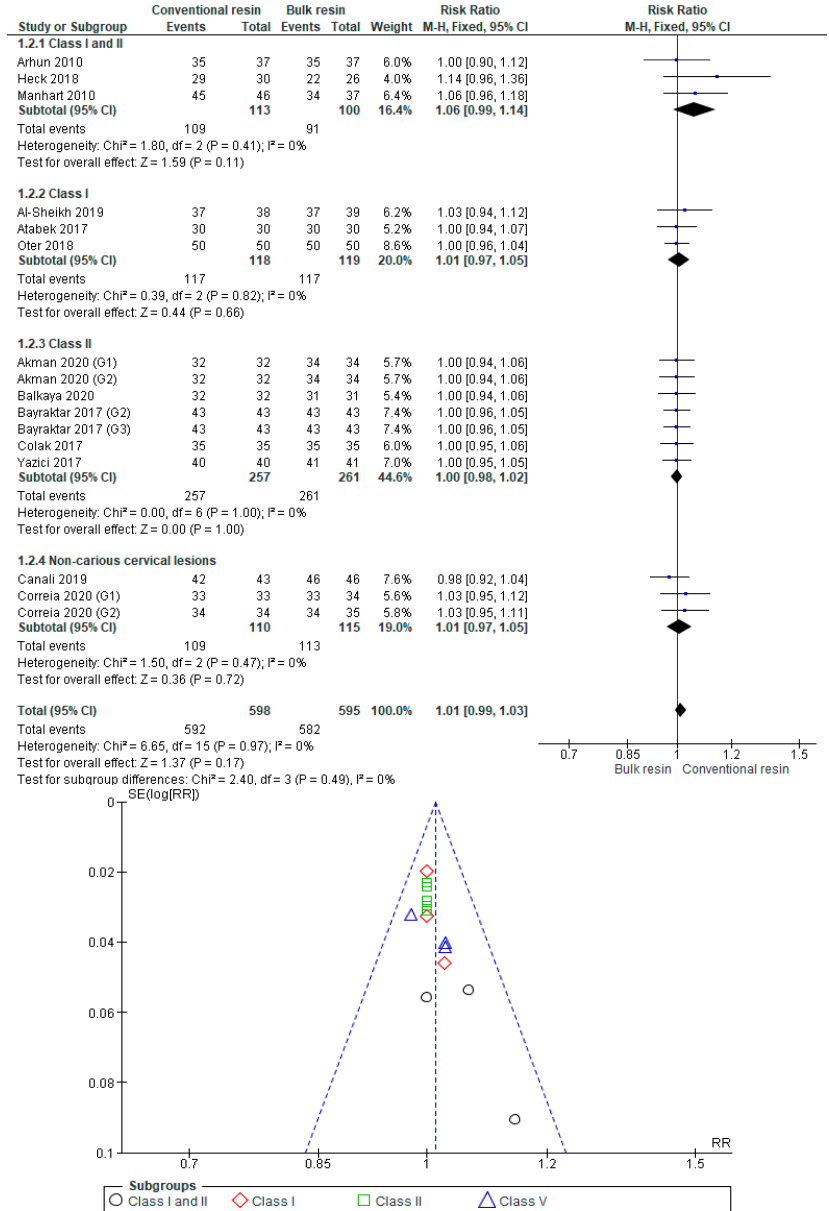
Figure A2. Absence of Fractures: Conventional Resin versus Bulk Resin According to Type of Restoration.